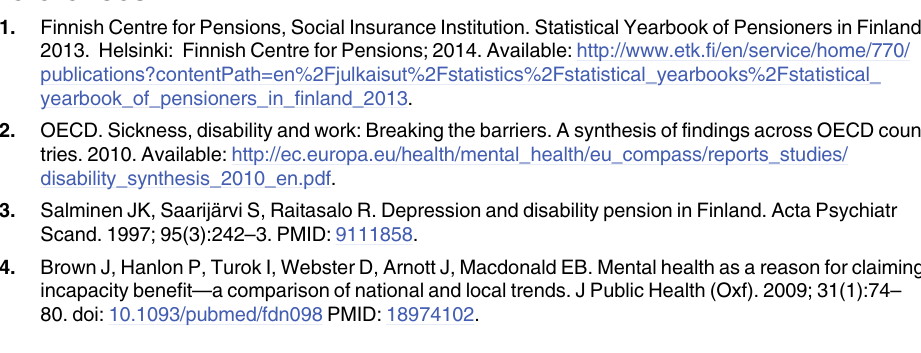
S1 Table. Proportion (%) of subjects with healthcare visits during military service by the service period. S2 Table. Median and interquartile range of healthcare visits during military service rela- tive to the service length (visits per service